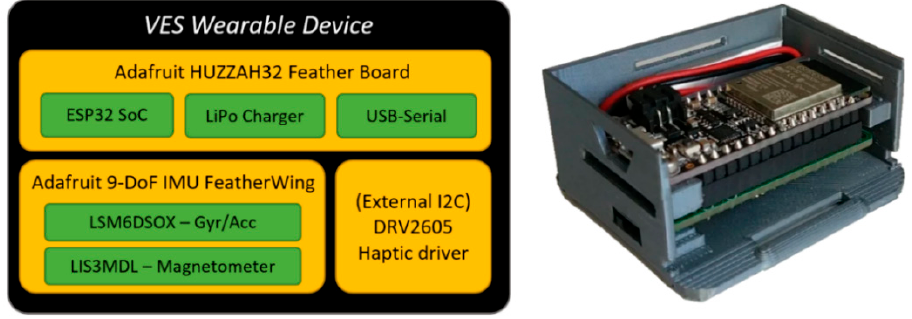
Figure 1. VES Wearable device and hardware architecture.